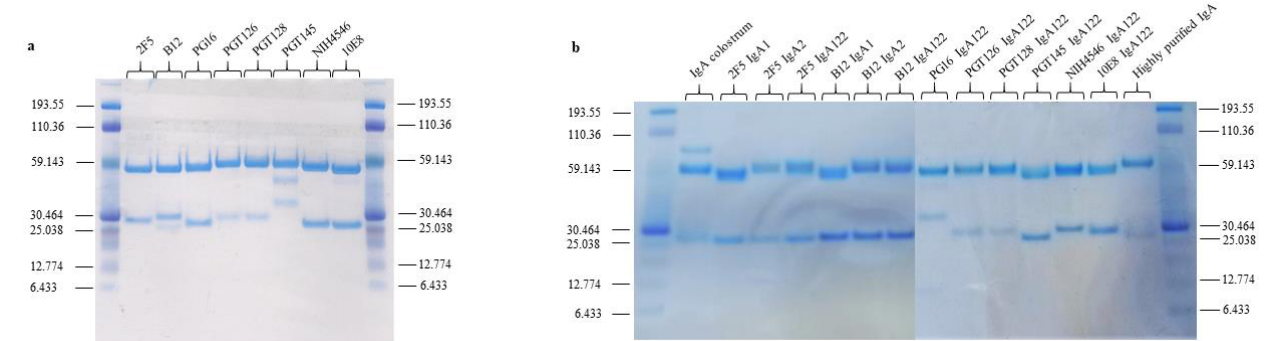
Figure 1. Characterization of the different bNAb isotypes: ( a ) Separation of bNAbs IgG and ( b ) IgA isotypes on SDS-PAGE (Bis-Tris 4–12%). An amount of 10 µ g of the corresponding antibody was loaded on the gel. The first and last lanes of each gel correspond to the molecular weight marker. Two IgA controls were used: colostrum IgA and a highly purified IgA. Migration was performed at 150 V for 1 h.